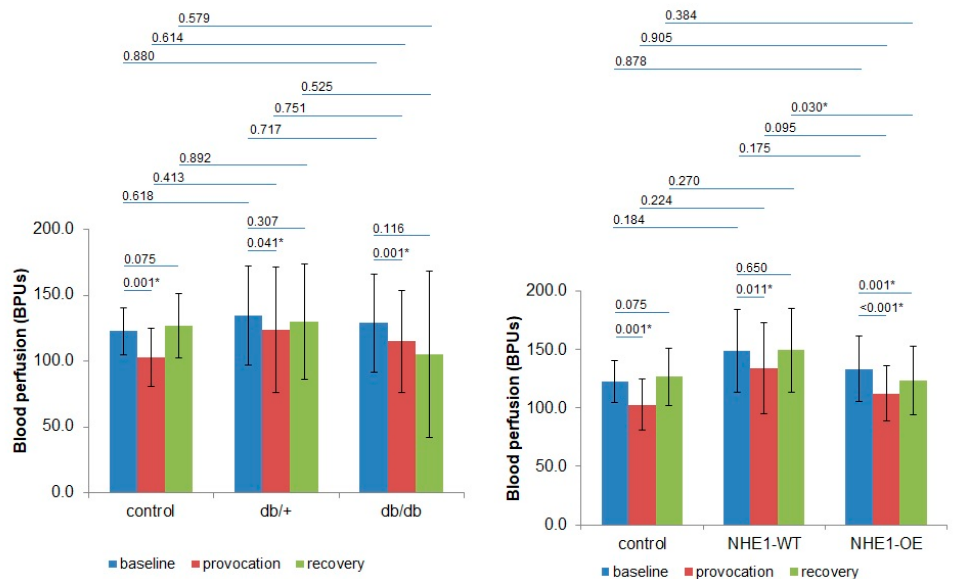
Figure 1. Mean hind limb perfusion changes, expressed in BPUs (blood perfusion arbitrary units) registered in the diabetic (DB) group ( left , 8 db/db and 8 db/+) and in the cardiac hypertrophy (CH) group ( right , 8 NHE1-WT and 9 NHE1-OE) versus the Control group ( n = 8), during the different phases of the experimental protocol. Statistical comparison, and respective p values between sub-groups is also shown (m ± sd: mean ± standard deviation; * p < 0.05).